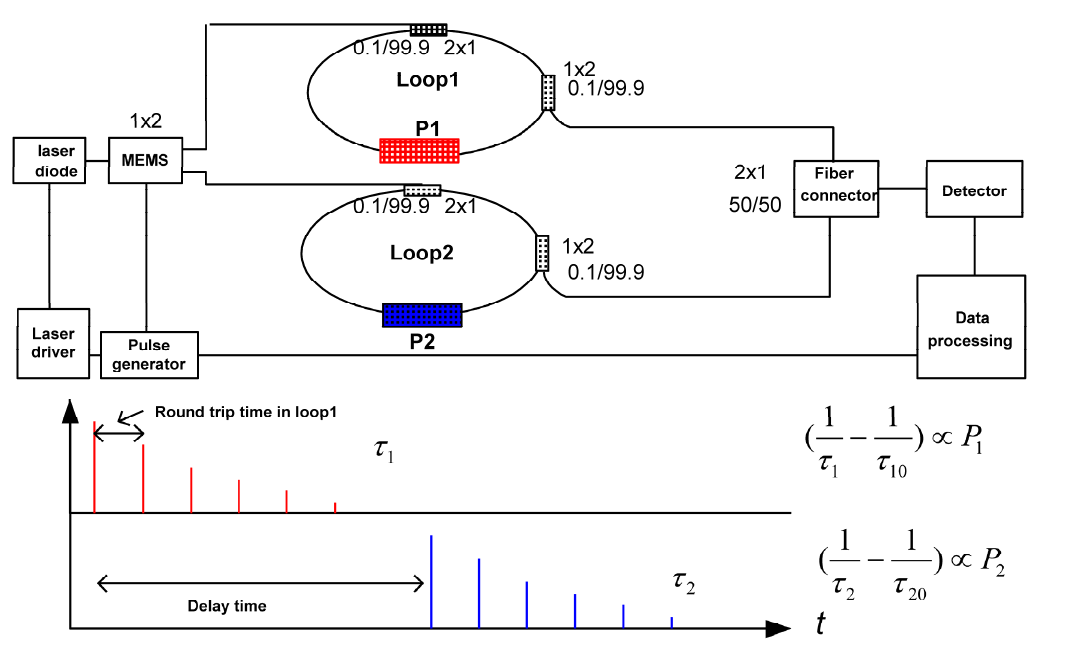
Figure 8. Proposed concept of the sensor platform in a parallel configuration. A platform consisting of two sensor units is used to illustrate the